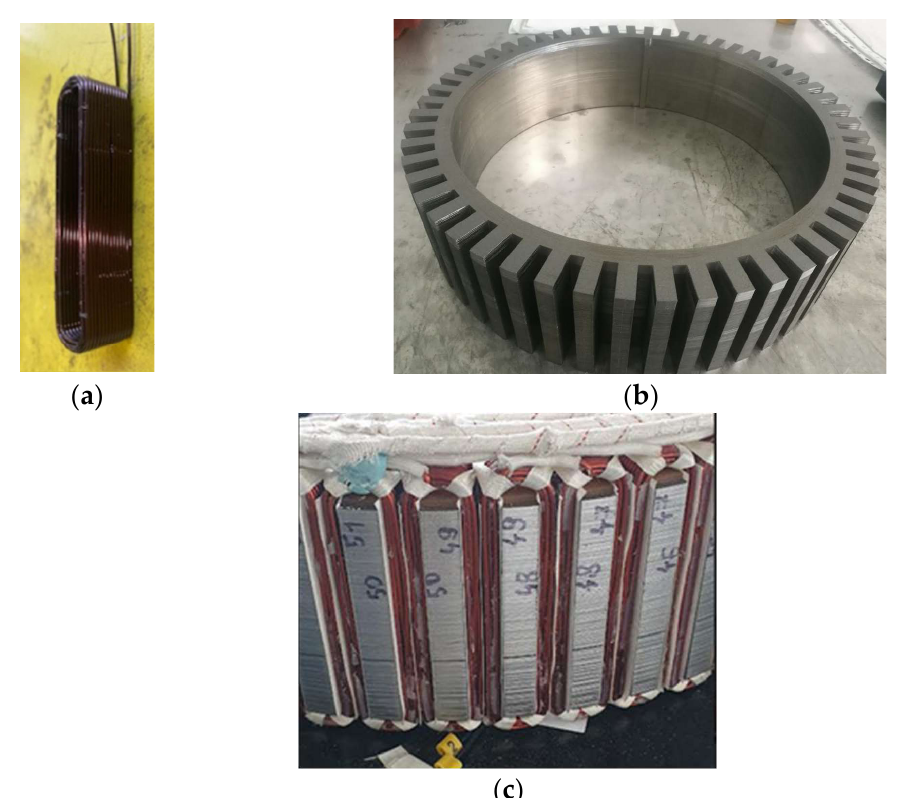
Figure 2. Physical model of: ( a ) winding coil; ( b ) magnetic core; ( c ) stator. The drive consists of two motors installed in the rear driving axle of the car. Each of the motors will be powered by a separate inverter. The assumed battery supply voltage is U DC = 400 V.